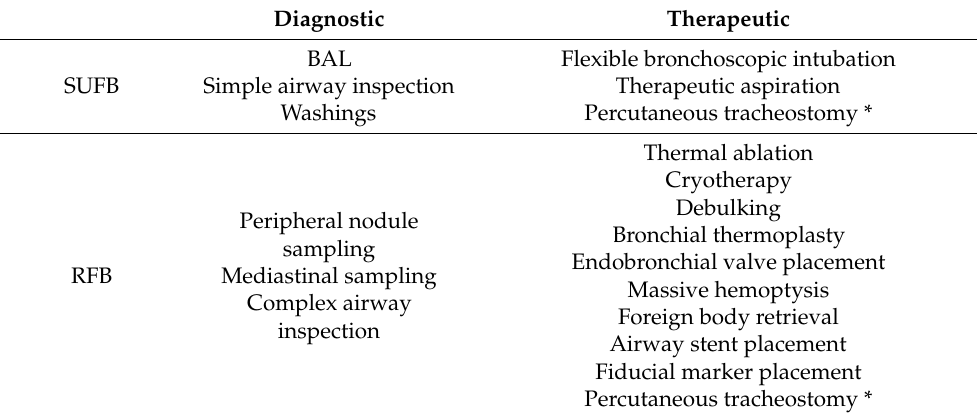
Table 1. Recommended indications for SUFB and